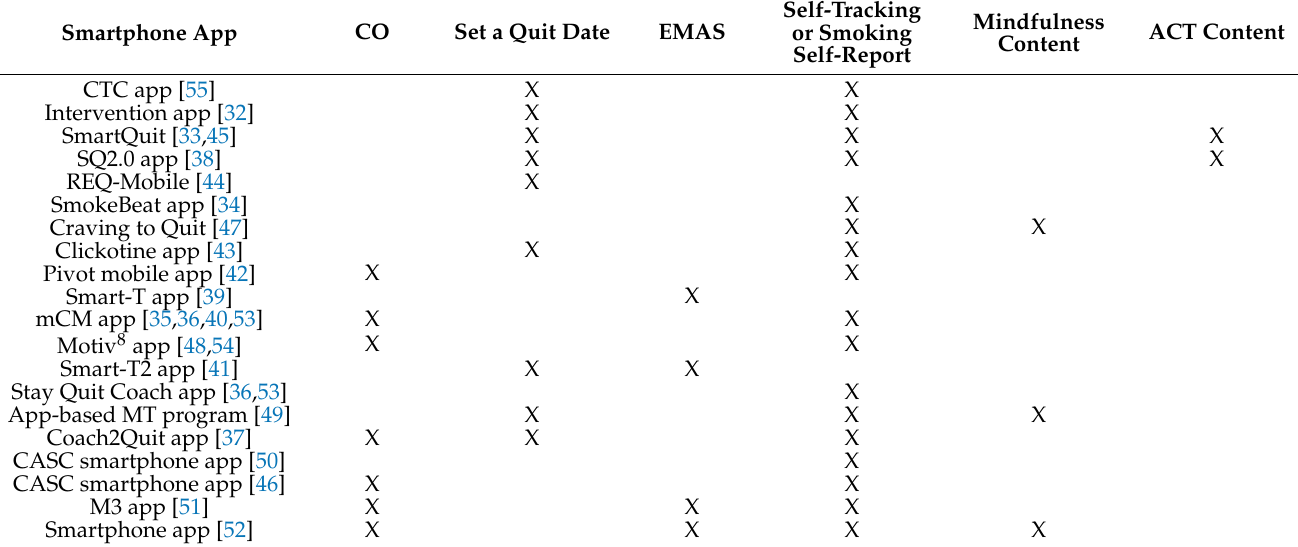
Table 4. Features of the apps included in the studies.